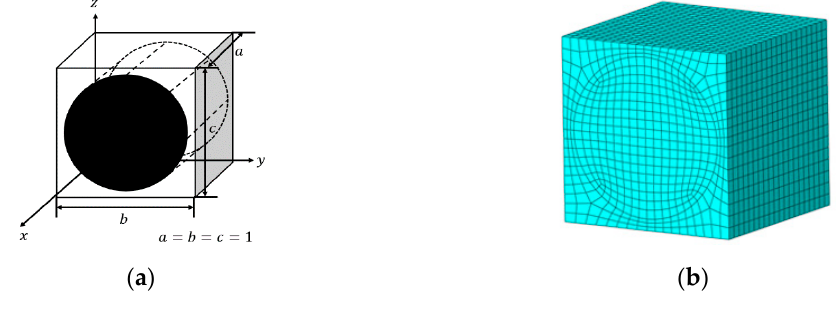
Figure 3. Square unit cells for carbon/epoxy composites: ( a ) Geometrical model of micro-level unit cell of fabric composites; ( b ) Finite element model of unit cell for unidirectional composites.